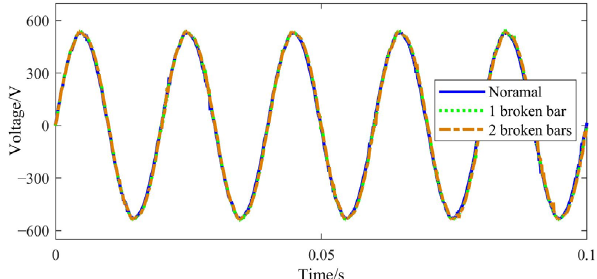
Figure 16. Stator voltage time-domain signal.